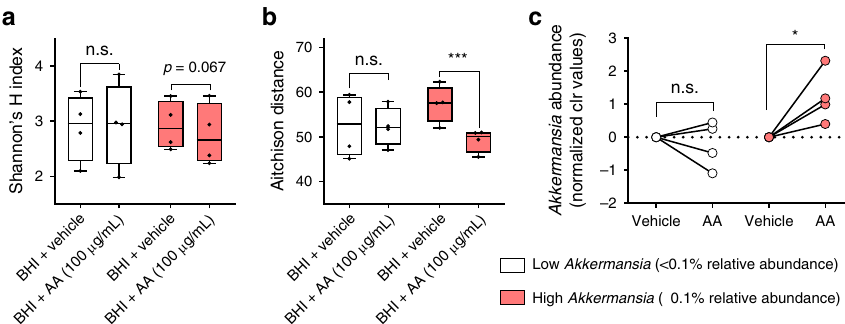
Fig. 2 In vitro incubation of patient fecal samples with abiraterone acetate (AA). Freshly collected fecal samples from donors not receiving any form of prostate cancer treatment ( n = 8) were transferred to BHI media supplemented with 100 μ g/mL of abiraterone acetate (AA) or vehicle (EtOH). Samples were incubated anaerobically at 37 °C for 48 h prior to 16S rRNA gene sequencing. a Alpha diversity was measured via Shannon ’ s H index and b beta diversity was measured via Aitchison distance between samples within the same group. Data represent the median (line in box), IQR (box), and minimum/ maximum (whiskers) of n = 4 low Akkermansia and n = 4 high Akkermansia samples. Statistical comparisons shown for separate Wilcoxon ’ s matched-pairs tests with multiple comparisons corrected using the Benjamini – Hochberg FDR method. c Differences in Akkermansia abundances following incubation with AA compared to vehicle. Data shown represent log 10 clr-transformed relative abundances normalized to the vehicle group for each sample. Statistics shown are derived from differential abundance analysis using ALDEx2 software in R. *** P = 0.0005, * p = 0.0358, and n.s. = not signi fi